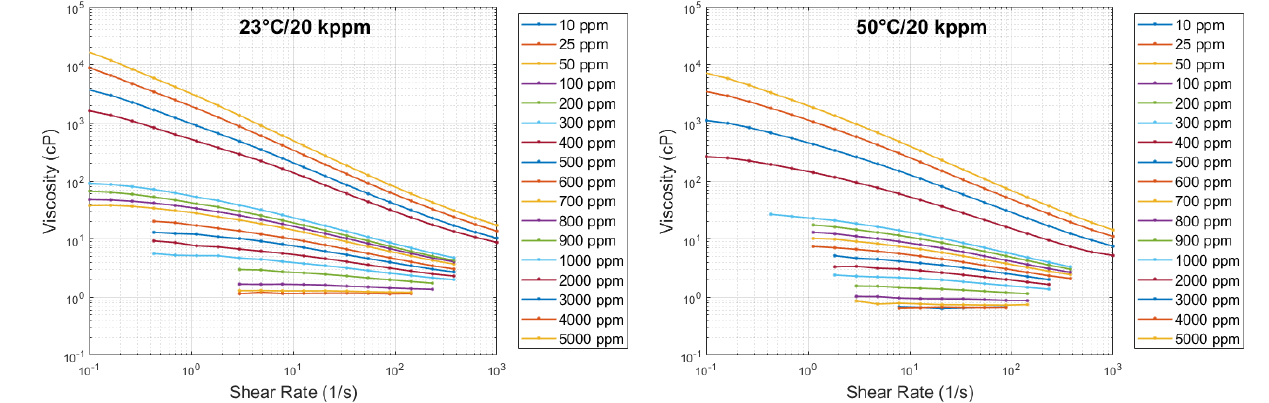
Figure 6: Flow curves graph at 50 ∘ C and 20.000 ppm of NaCl